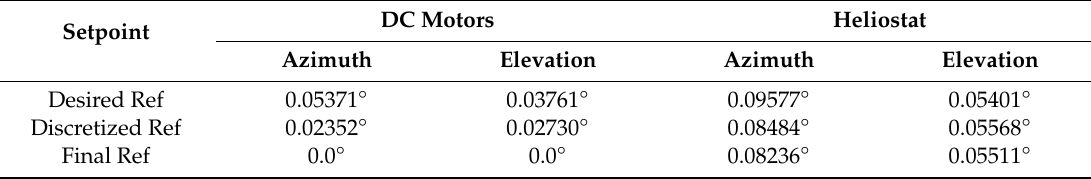
Figure 24. Error of the orientation control: for the DC motors with no load compared to the desired reference ( a ), for the heliostat compared to the desired reference ( b ), for the DC motors with no load compared to the final reference ( c ), and for the heliostat compared to the final reference ( d ). Table 6. Orientation control mean squared error